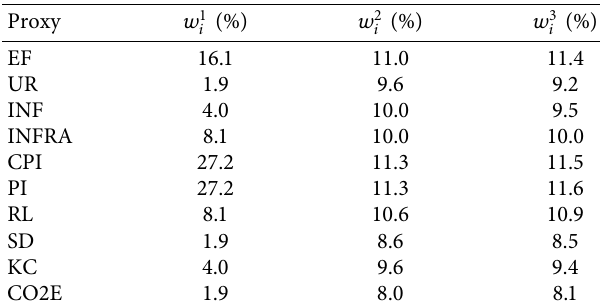
Table 14: A comparison of the different weights computed using different